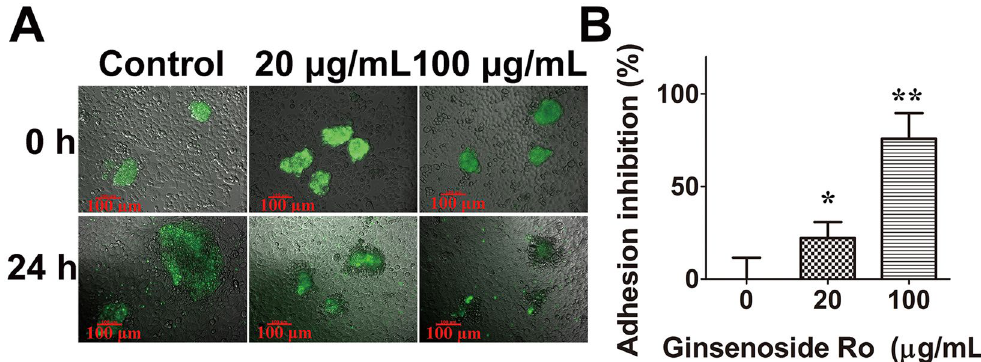
Figure 2. Inhibition of biomimetic human embryo implantation to endometrium by ginsenoside Ro. ( A ) Laser confocal microscopy imaging showed the significant inhibition by ginsenoside Ro of implantation of human spheroid embryo JEG-3 (green) to confluent monolayered human endometrial cells RL95-2 after 24 h co-incubation. ( B ) Concentration–dependent inhibition by ginsenoside Ro of spheroid embryo outgrowth of JEG-3 cells to human endometrial RL95-2 cells. Each bar represents the mean ± SD (n = 3).